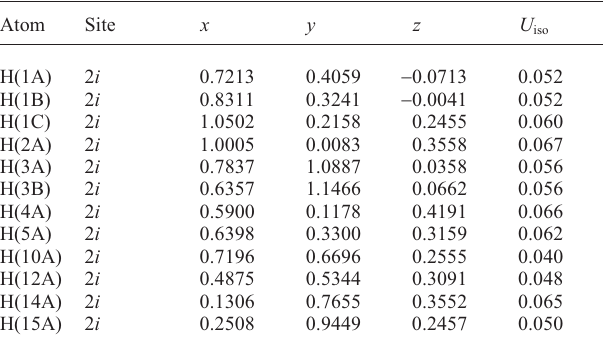
Table 2. Atomic coordinates and displacement parameters (in Å 2 )